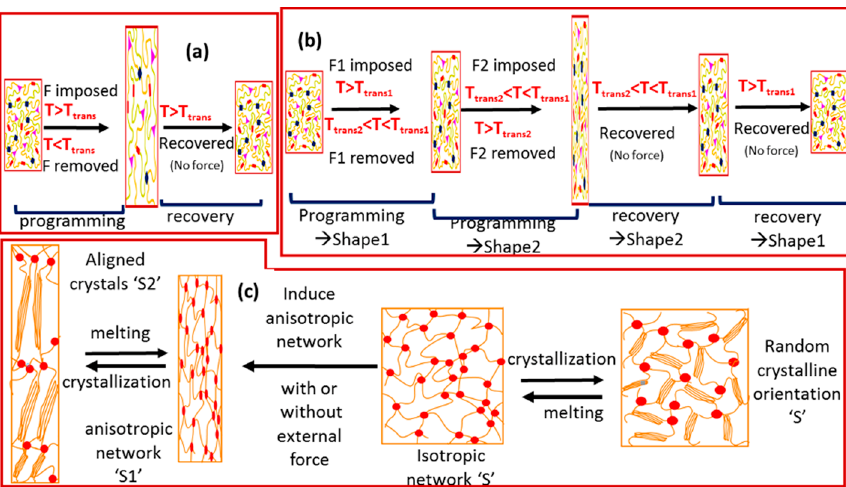
Figure 1. Schematic illustration of ( a ) dual shape-memory, ( b ) multiple shape-memory effect and ( c ) mechanism for 2W-SME of the cross-linked crystalline polymer network with an isotropic and anisotropic network structure (reproduced with permission [28] . Copyrights (2015), Elsevier).